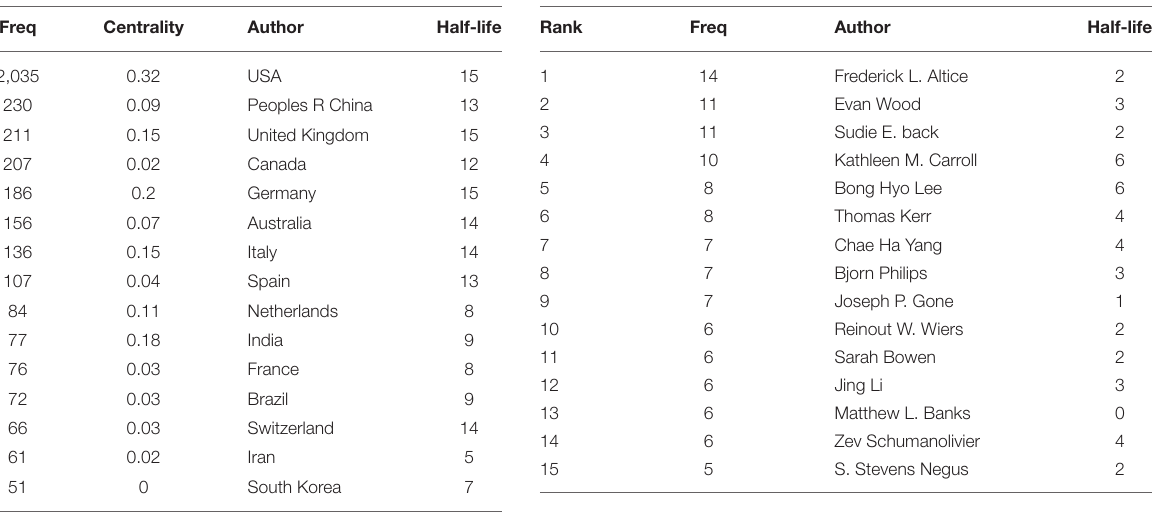
TABLE 3 | Top 15 authors related to complementary and alternative medicine for substance use